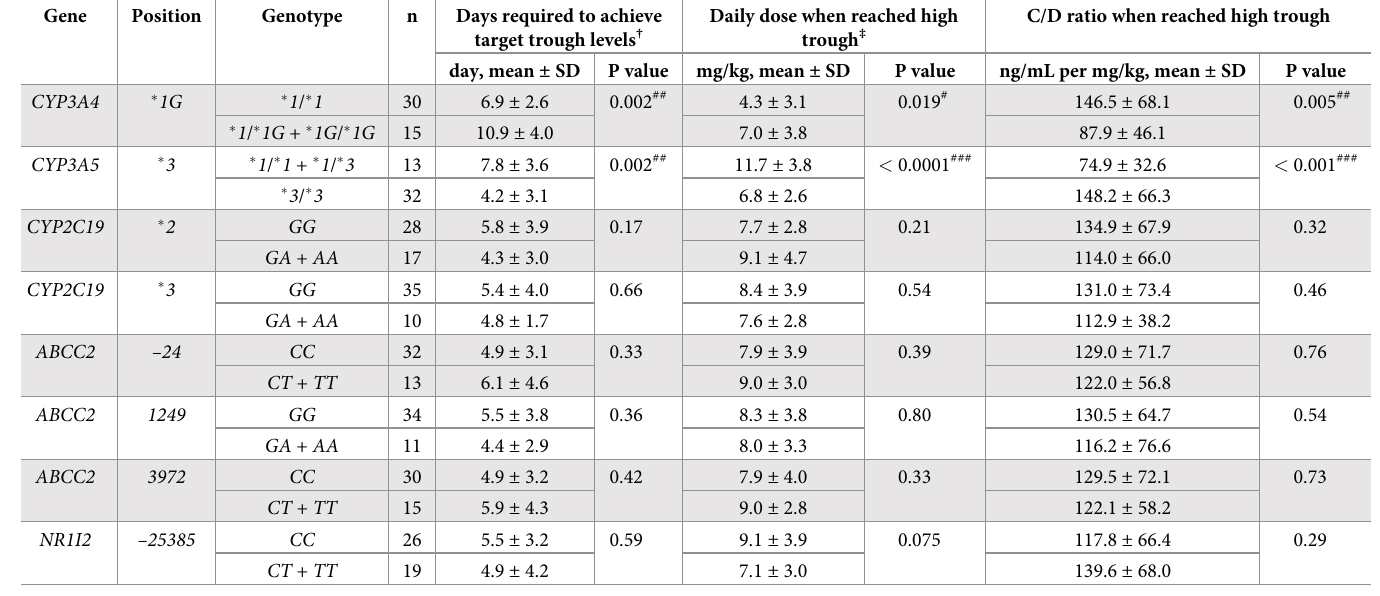
Table 3. Relationship between genetic polymorphism and pharmacokinetics. Gene Position